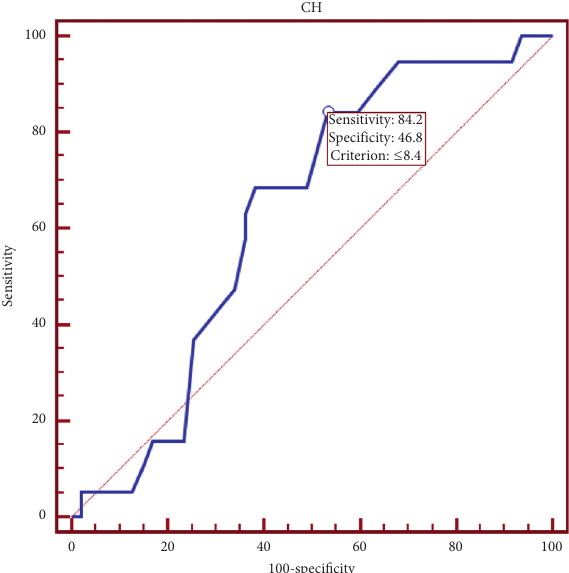
Figure 8: Corneal hysteresis receiver operating characteristic curve data.